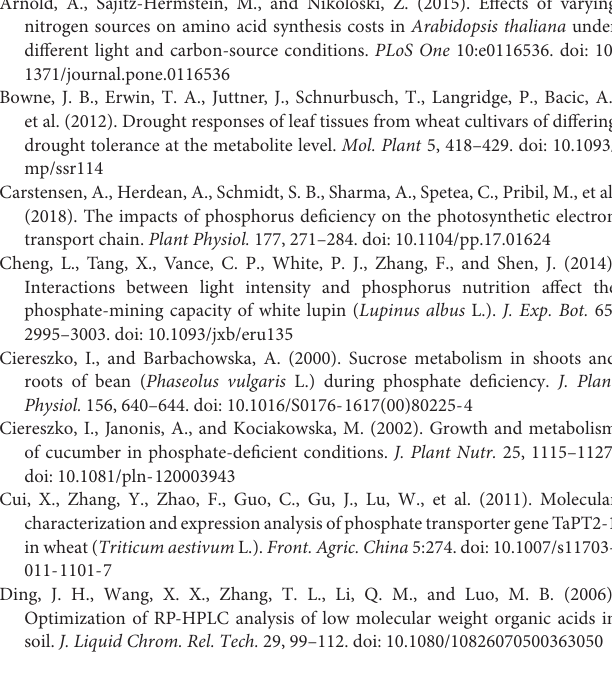
color: significant at P < 0.05 with Bonferroni correction. TABLE S5 | Effect of P supply on succinic, maleic, oxalic and citric acids of two wheat genotypes RAC875 and Wyalkatchem at 41 days after sowing (DAS). TABLE S6 | Effect of P supply on succinic, maleic, oxalic and citric acid concentrations of each wheat genotype, RAC875, and Wyalkatchem at 41 DAS (One-way Anova analysis). TABLE S7 | Comparisons for succinic, maleic, oxalic, and citric acids between P supply of each wheat genotype (one-way Anova, Turkey